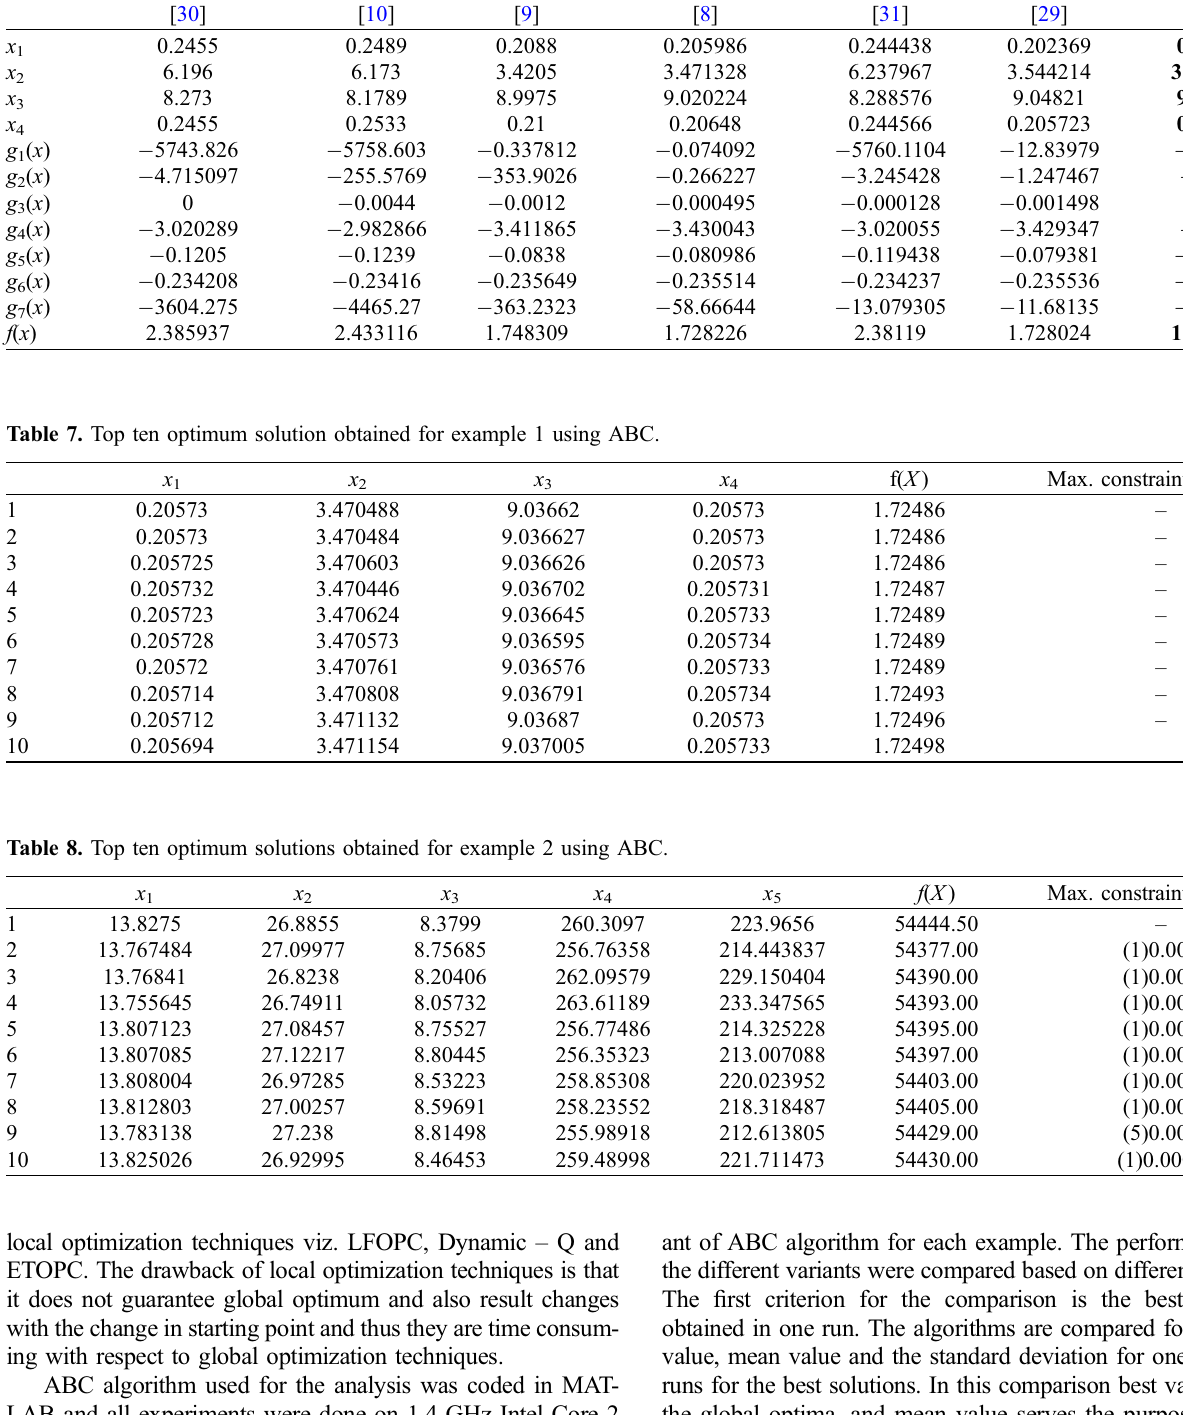
Table 6. Comparison of results obtained by different researchers using different optimization techniques for Example 1 (welded beam). Ragsdell & Phillips Deb Coello Coello & Montes